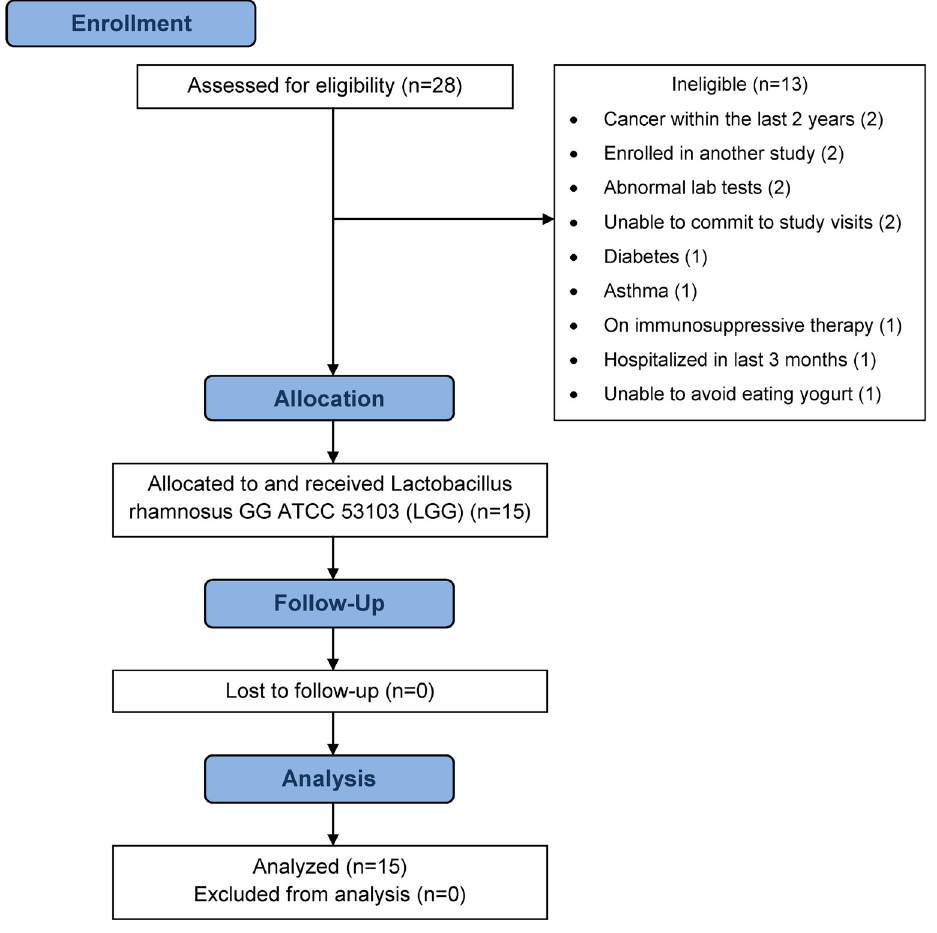
Fig 1. Participant flow